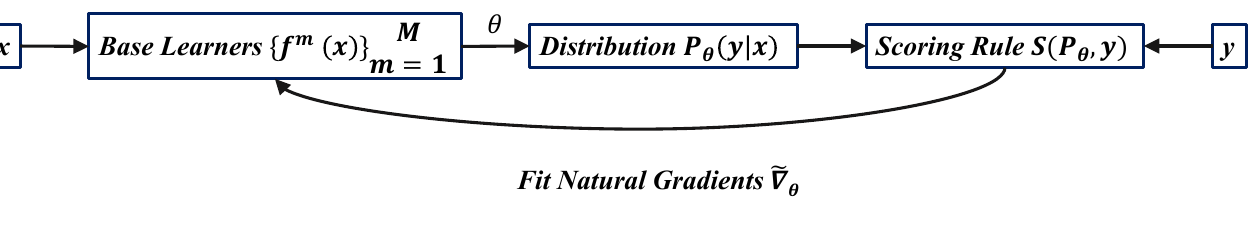
�𝜵𝜵 𝜽𝜽 Figure A5. Conceptual representation of the NGBoost model (Source: Duan et al.